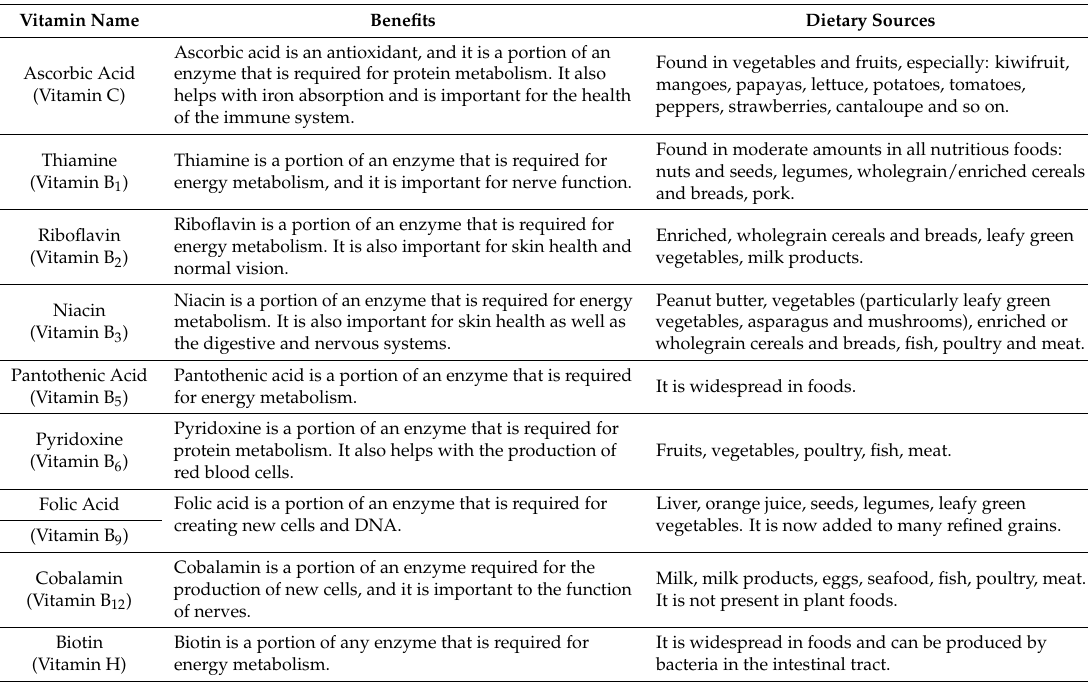
Table 2. List of water-soluble vitamins